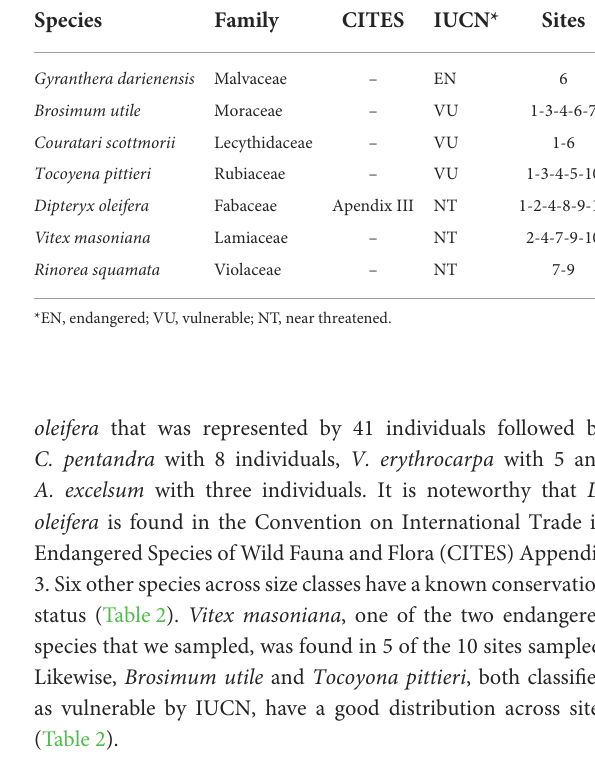
FIGURE9 Comparison of manually measured tree heights (INV) for different species with that reported in the literature as the MaxH by Condit et al. (2020). For figure clarity species are coded as individual numbers (1–66). Please refer to Supplementary Table S3 for respective species names. The colored triangle indicates species that exceed the previously reported MaxH. Black line is the 1:1 line.